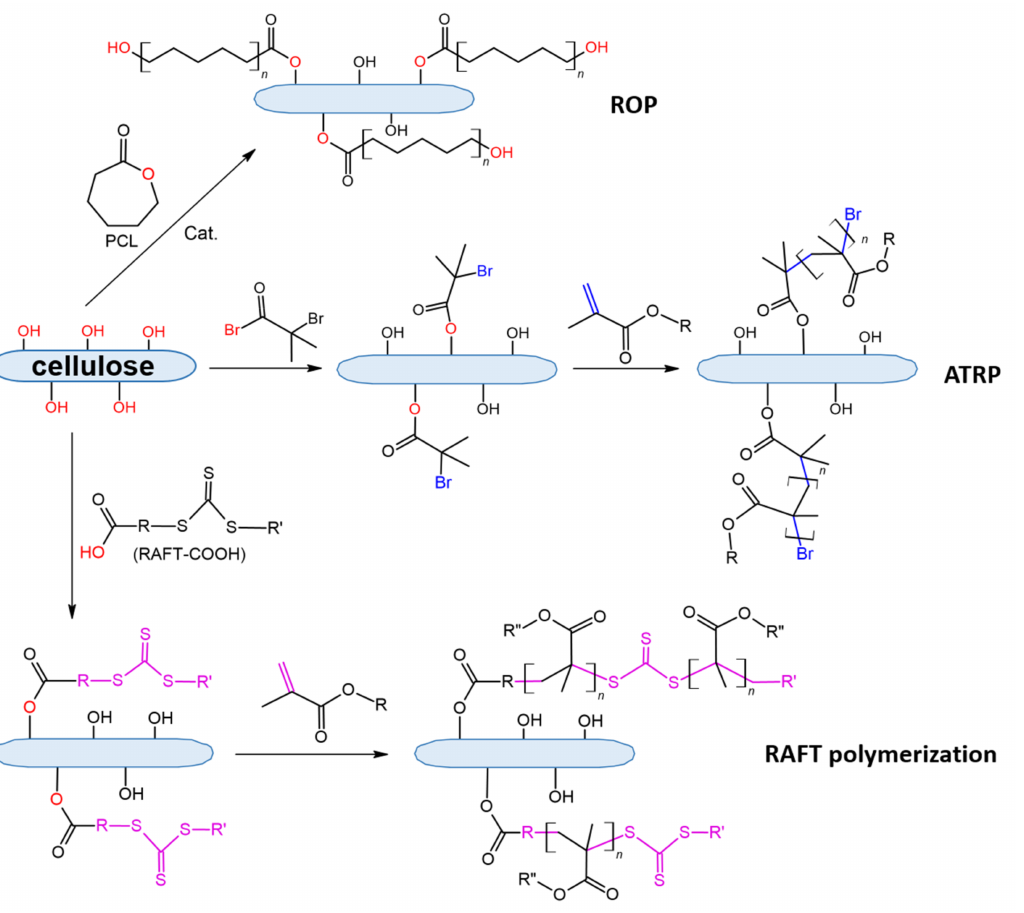
Figure 11. Examples of cellulose modification by the grafting “from” technique (the details and corresponding references are presented in Table